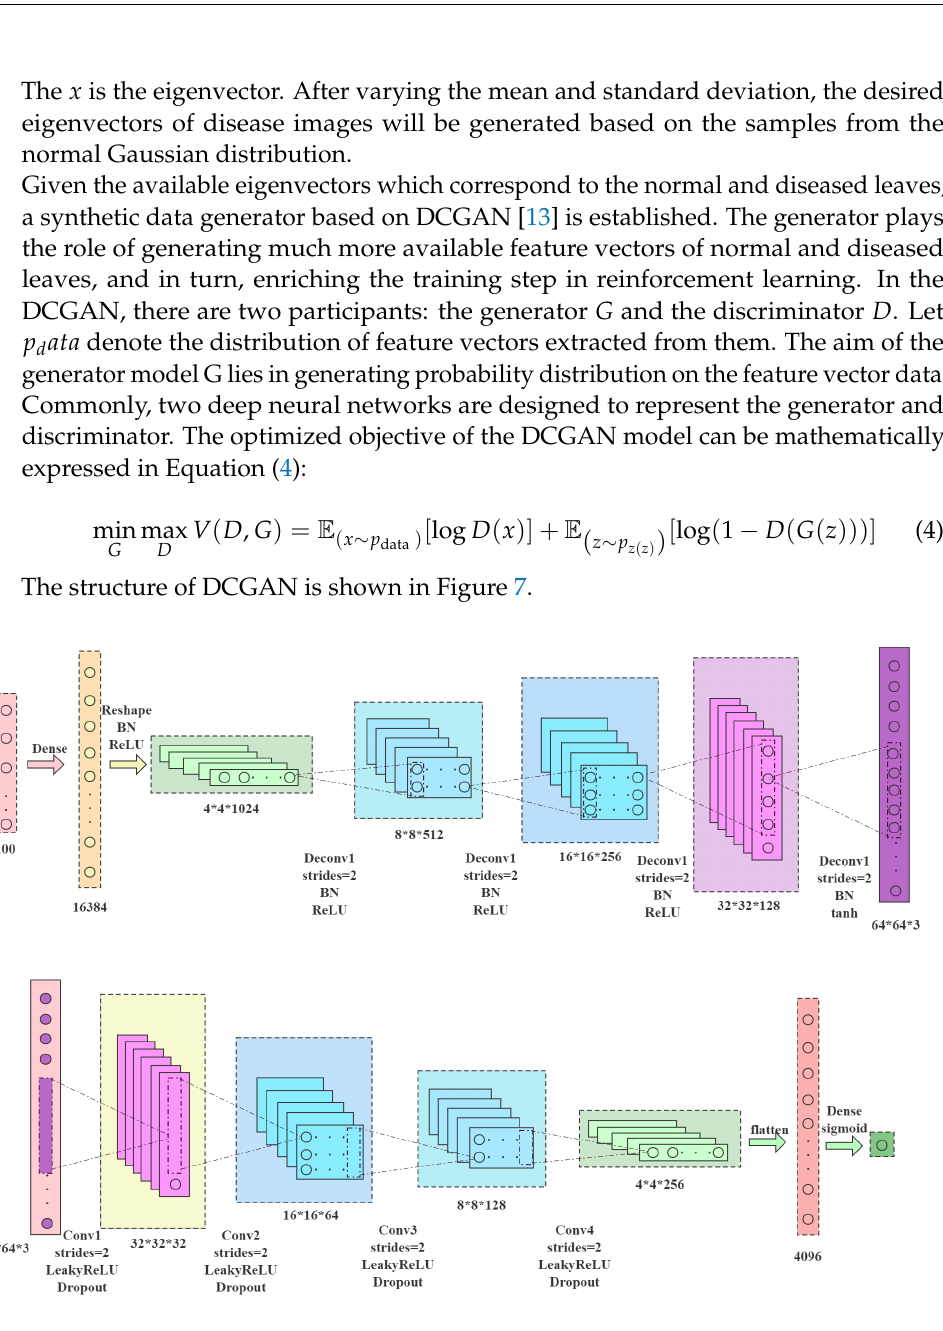
Figure 7. Structure of DCGAN.